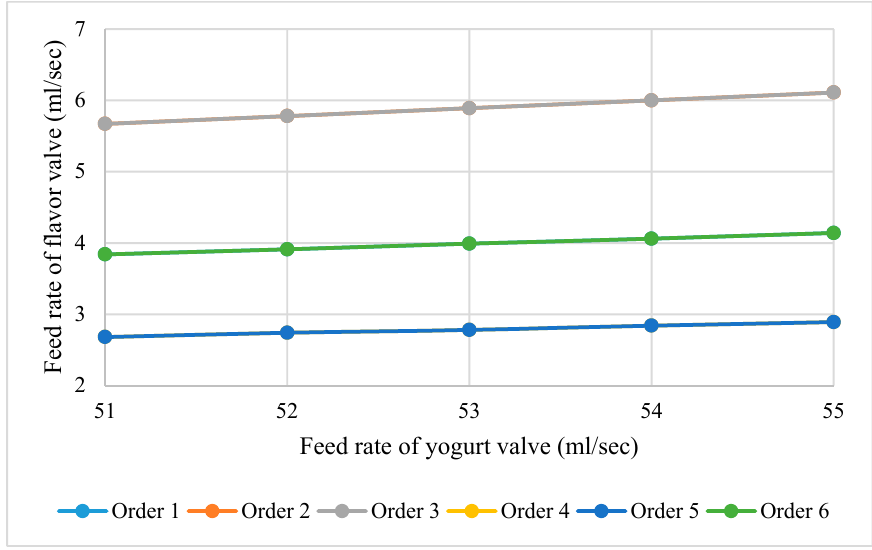
the higher ratio of the flavor of yogurt in a required volume of a cup, the change in the feed rate of flavor in the case of orders 2 and 3 is greater than 1 and 6, and 4 and 5.